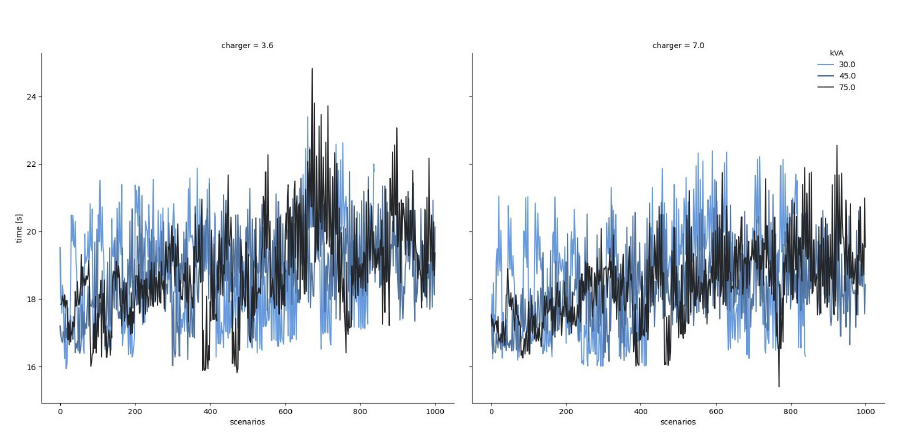
Figure 12. Computational time results for low voltage—Feeder